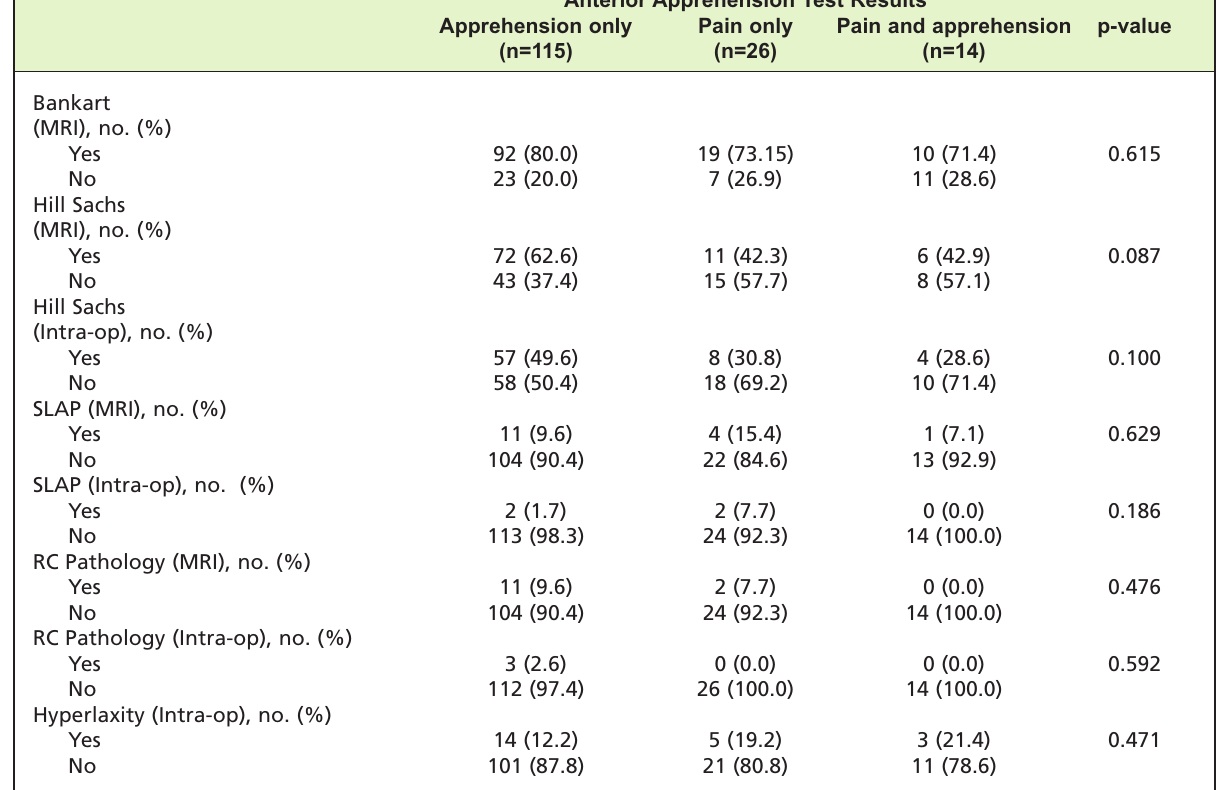
MRI and intra-operative arthroscopy Table III: